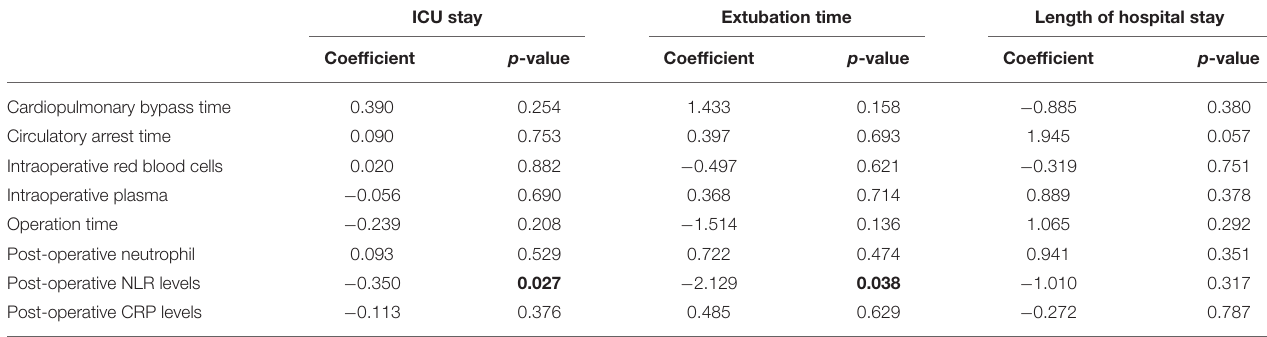
TABLE 3 | Multivariate analysis for duration of ICU stay, extubation time and length of hospital